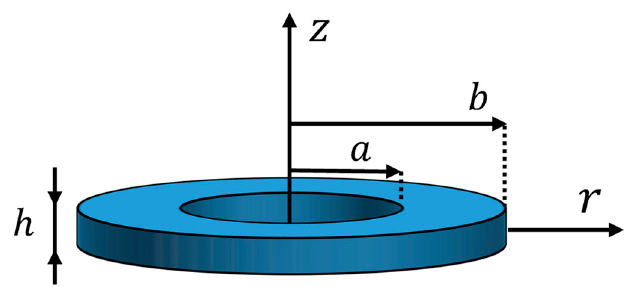
Figure 1. Schematic view of the multiscale hybrid annular plate, related parameters, and coordination.